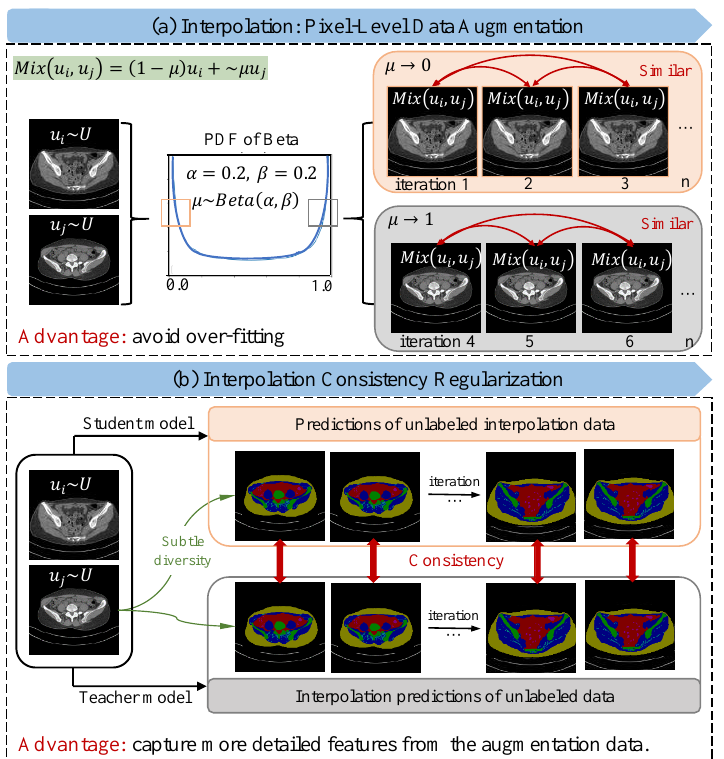
Figure 3. Illustration of interpolation consistency regularization, taking the Multi-tissue Pelvic dataset as an example. ( a ) describes the data augmentation process by pixel level interpolation, “ µ ” is the interpolation factor and follows the Beta distribution. The “PDF” represents the probability‑ density function of Beta distribution, and “ α ” and “ β ” are the parameters of beta distribution. ( b ) is the interpolation consistency regularization process.